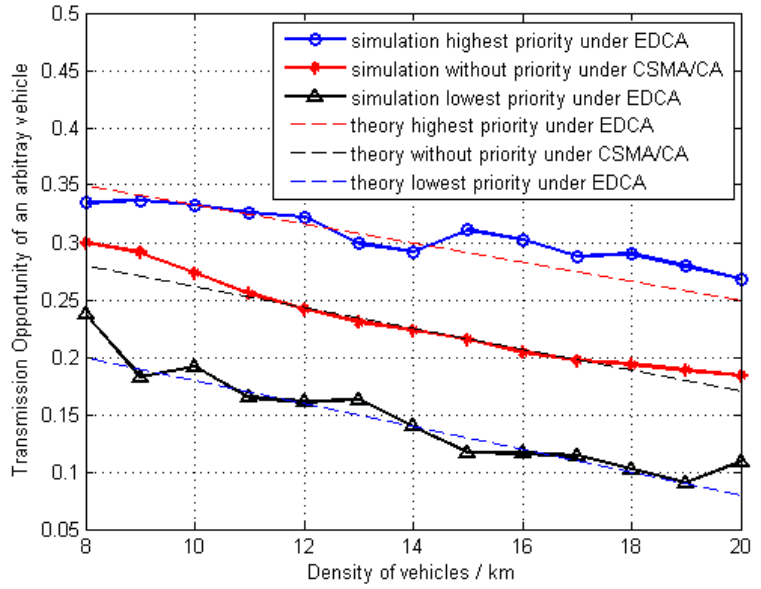
Figure 5. Transmission opportunity with different priorities versus the density of the active transmitters.